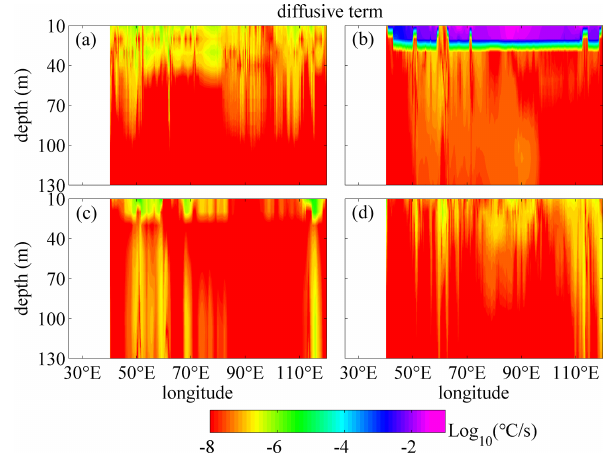
Figure 3. The same as Fig. 2, but in